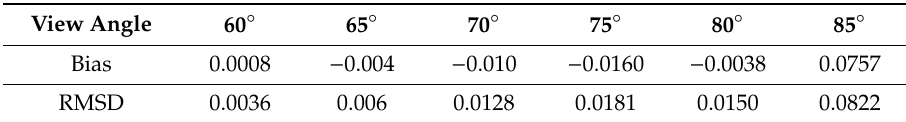
Table 2. The bias and RMSD values between the simulated sea surface emissivity values and the measurements of Branch et al. [29].